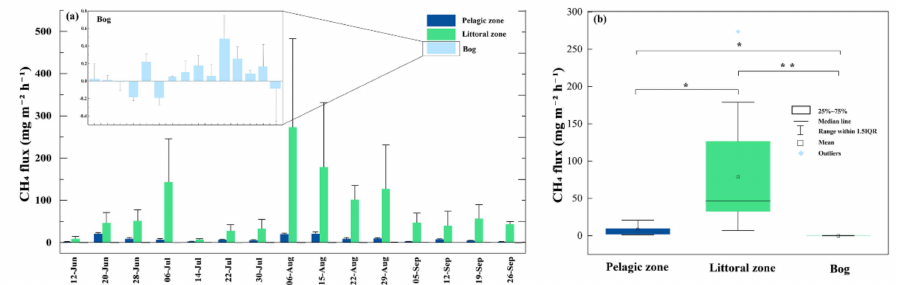
Figure 2. Temporal ( a ) and spatial ( b ) variation in CH 4 fluxes during the growing season. Bars represent mean ± SE. The empty squares, lines within each box, lower and upper edges and bars represent the means, median values, 25th and 75th, 10th, and 90th percentiles, respectively. * and ** indicate significant level at 0.05 and 0.01 level.